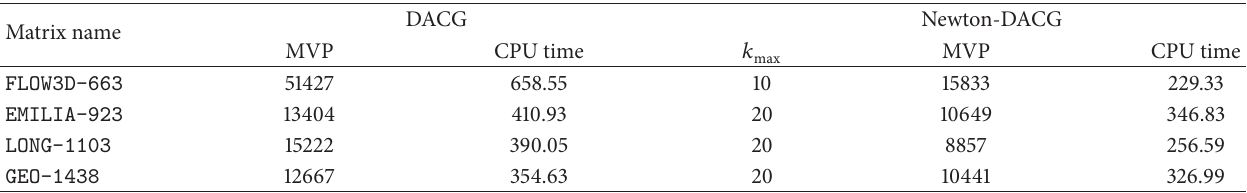
Table 5: Comparison between DACG and Newton-DACG for the four test problems on 𝑝 = 64 processors. Results on problem LONG-1103 = 0.5 . are obtained using 𝜏 DACG